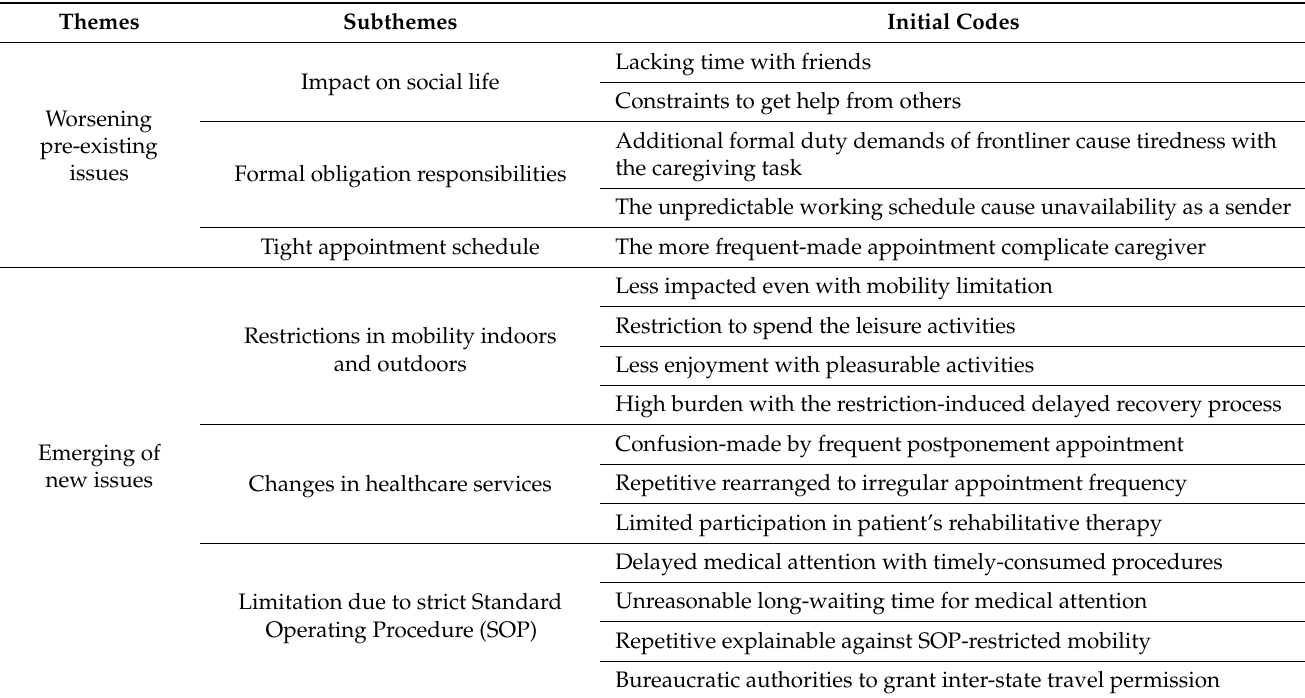
Table A2. Subthemes and themes on burdens and experiences in managing stroke patients during the pandemic